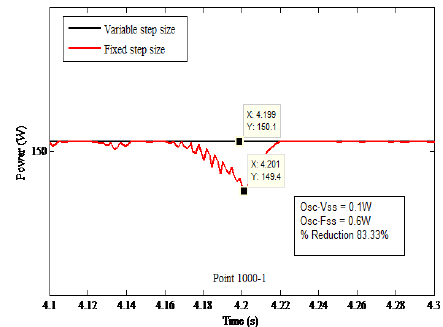
Fig. 13: Output power: Zoom in Point 1000-2.